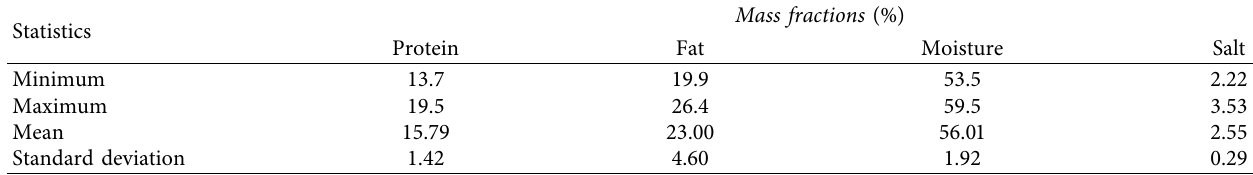
Table 4: Statistics of the chemical composition of the sausage samples.